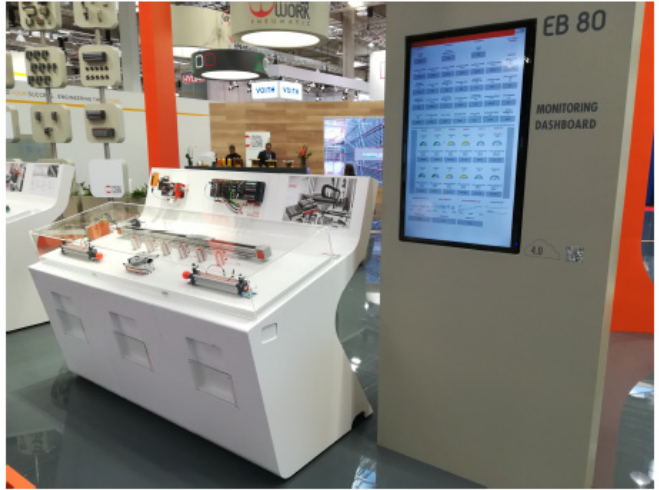
Figure 9. Real demo of the predictive maintenance systems based on Cloud services following the architecture of the use case in Figure 3.